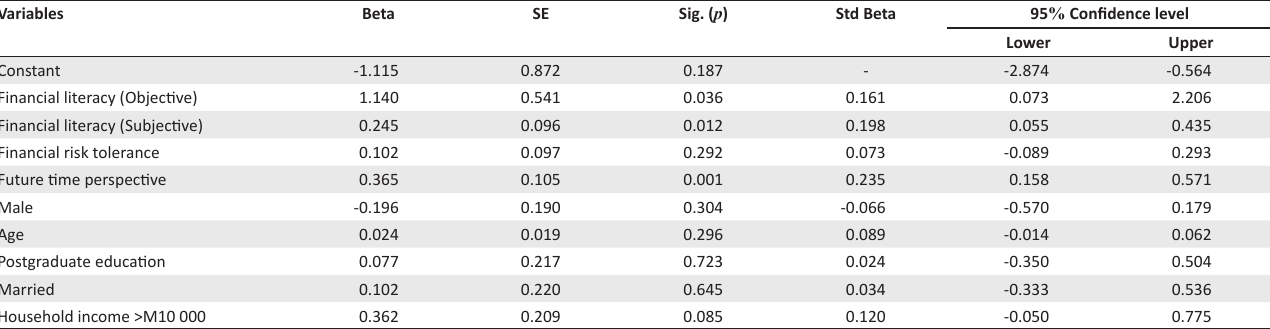
TABLE 3: Linear model of predictors for full sample. Variables